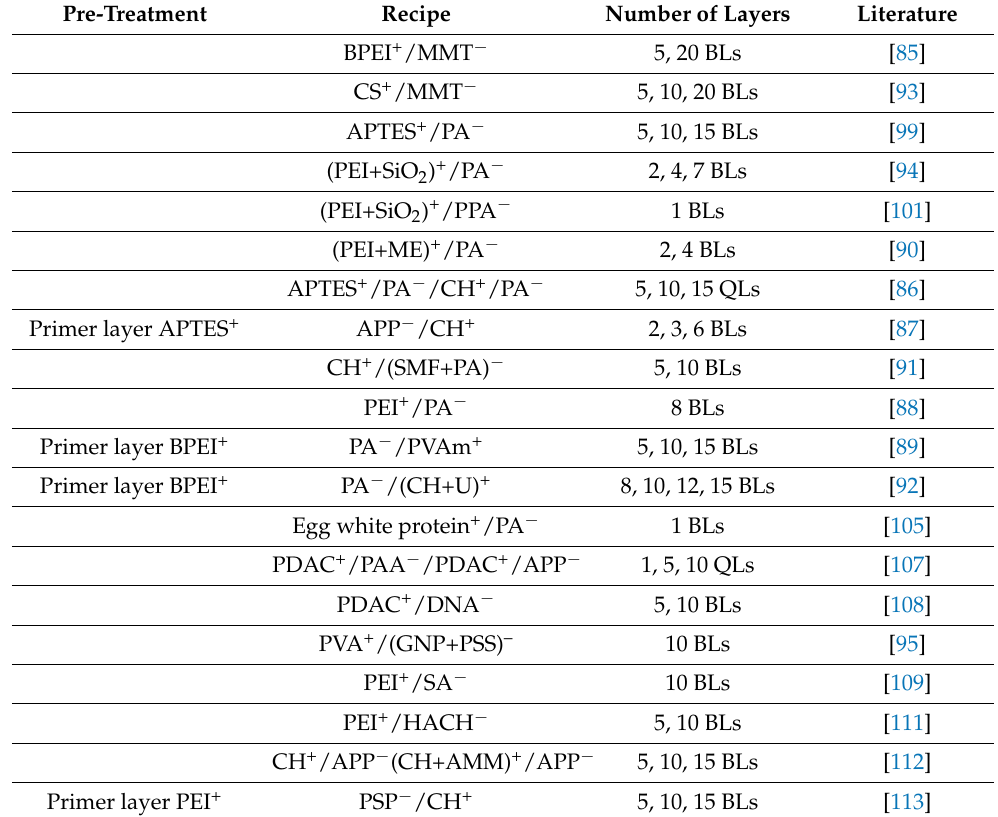
Table 1. Polyelectrolytes used to achieve FR of